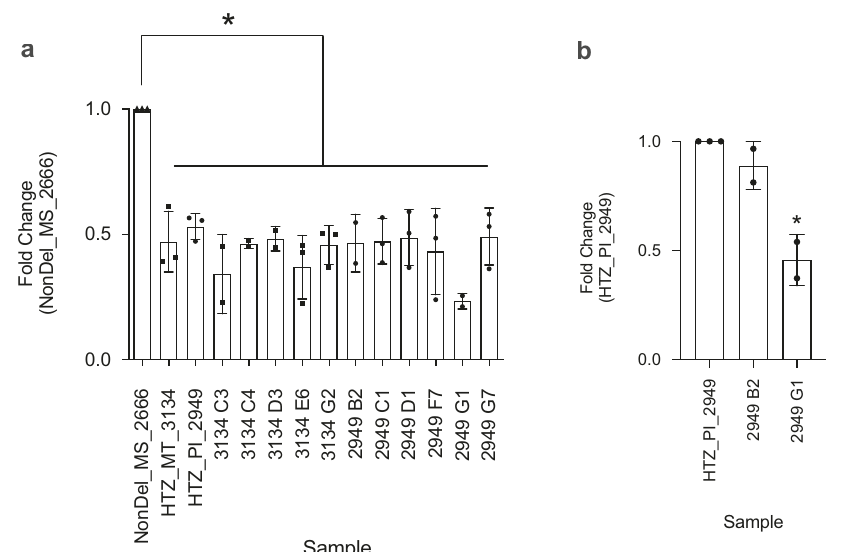
Fig. 2 Quantitative PCR con fi rms that intermediate read-depth pro fi les represent heterozygous deletions in L. infantum clones. a HTZ_PI_2949 and HTZ_MT_3134 were selected as representatives of isolates for which read-depth drops to ca. 50% between 1.122 Mb and 1.135 Mb on chr31 (see Supplementary Fig. 4). DNA from monoclonal subcultures established from these two isolates was analyzed in qPCR targeting LinJ.31.2380 (within the chr31 deletion site) and LinJ.31.2330 (downstream of the chr31 deletion site). Differences in Ct values for LinJ.31.2330 between each HTZ sample and the NonDel reference (NonDel_MS_2666) were used to normalize a fold change estimate at LinJ.31.2380 based on the ΔΔ Ct method by Livak and Schmittgen 75 . Student ’ s t -test was applied to test whether fold change estimates obtained from n = 3 independent reactions differed signi fi cantly from the 1 : 1 ratio represented by the reference sample. Results were considered signi fi cant at * p < 0.05 and indicate that intermediate read-depth pro fi les represent abundant heterozygous deletions as opposed to mixtures of deletion-carrying and non-deletion-type cells within isolates. b Fold change was calculated the same way for monoclonal HTZ subcultures using the parental isolate as the reference. Results indicate that “ unbalanced ” heterozygotes also occur, e.g., subclone 2949 G1 appears to contain three chromosome copies with the chr31 deletion and one copy